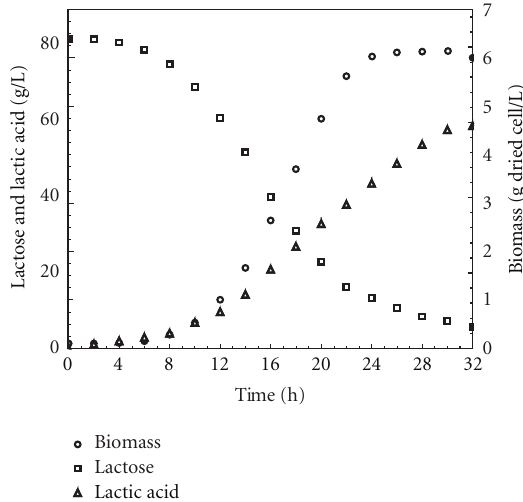
Figure 4: Concentrations of product, substrate, and biomass as a function of the time, under the best conditions (lactose 82g/L; yeast extract 23.36 g/L; temperature 40 ◦ C; pH